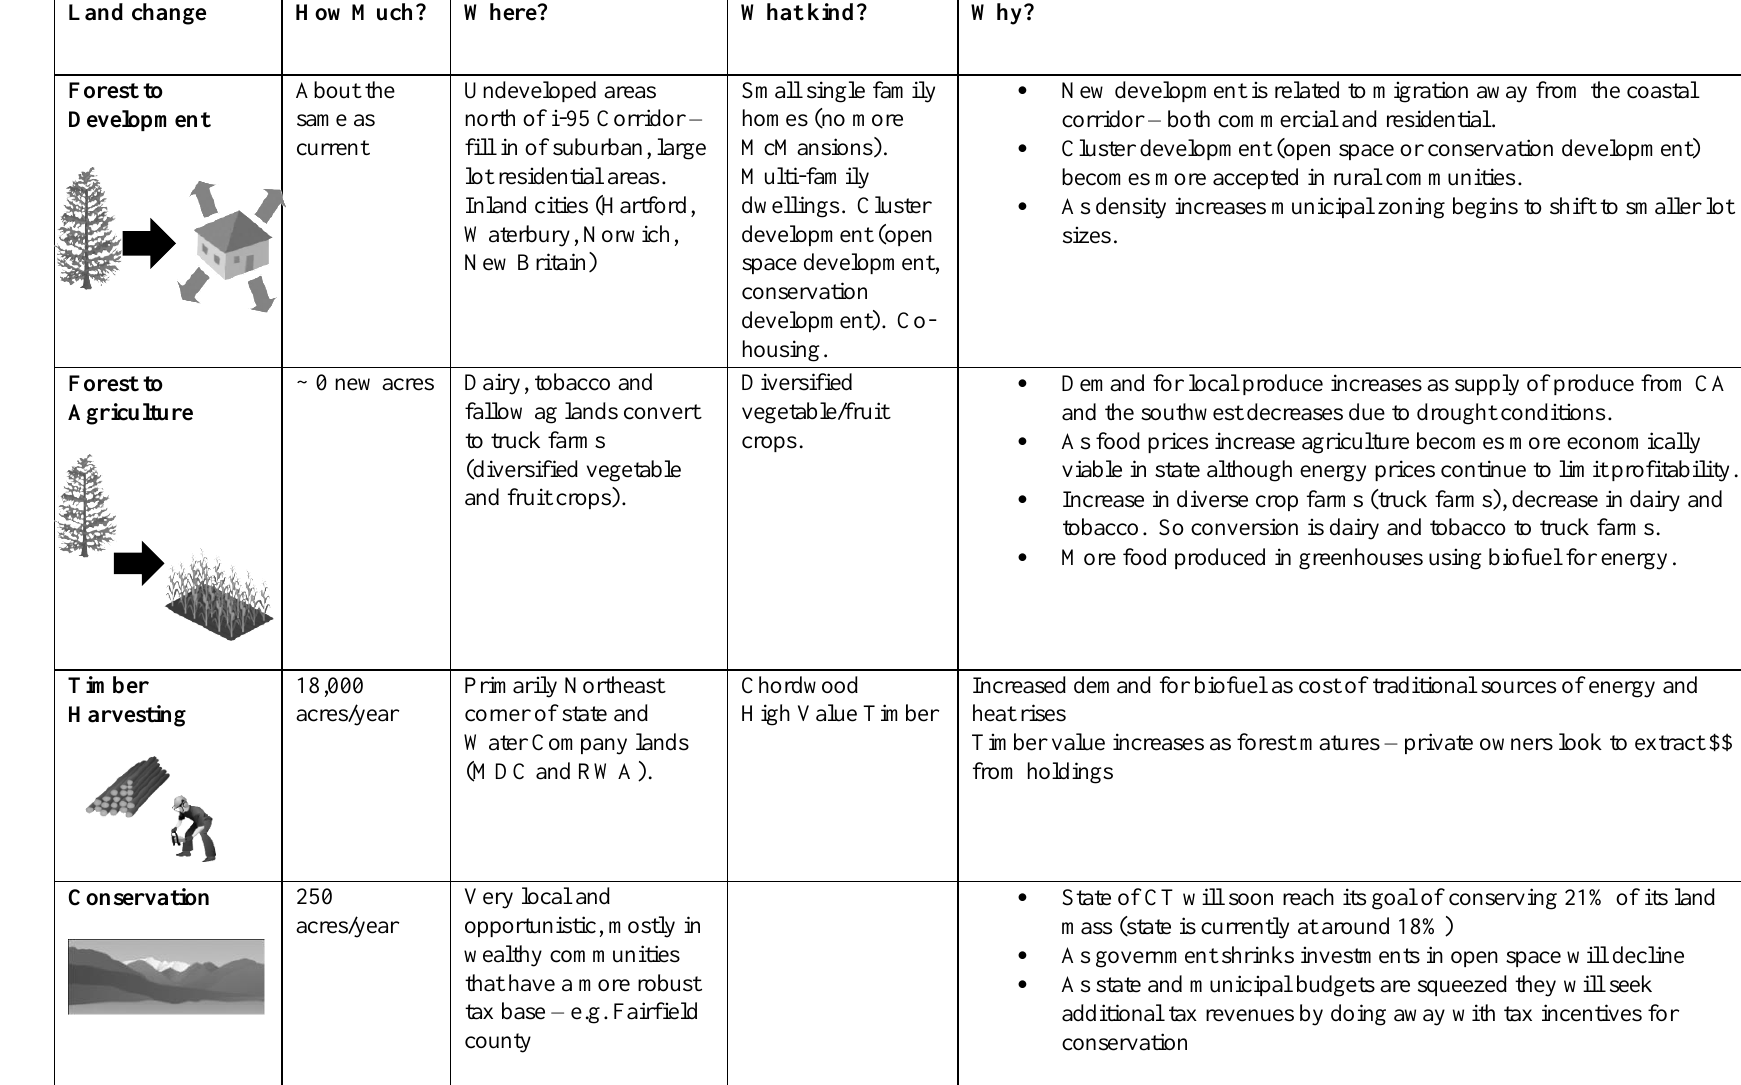
Table A2.15. Scenario 3: Bootstrap World Land